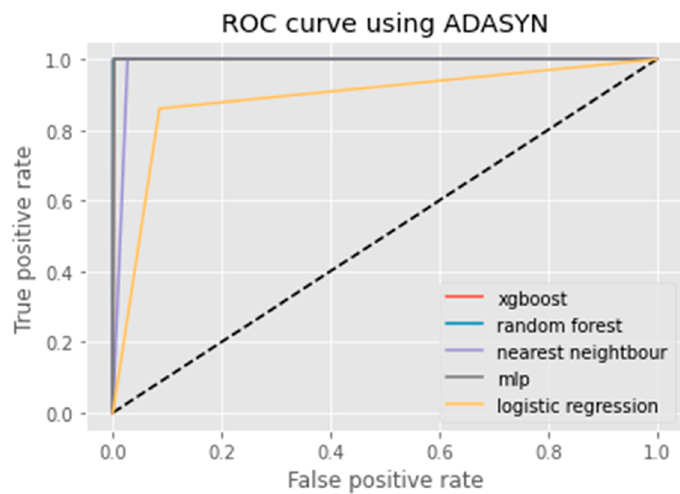
Figure 4. ROC curve using SMOTE.